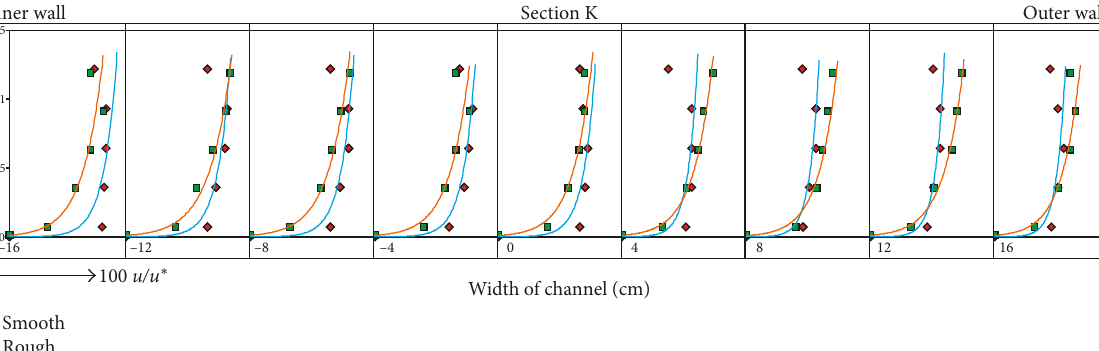
Figure 14: Comparison of velocity variation in section K.